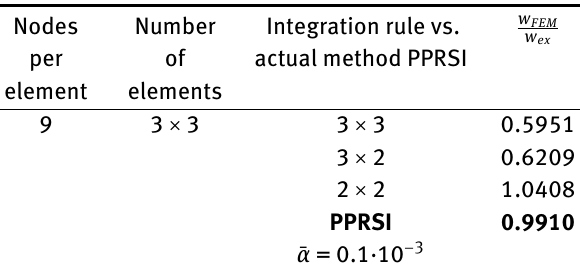
Table 2: Comparison of FE models, using nine-nodes element, for vertical displacement under the uniform vertical gravity load: finite element solution and PPRSI vs. exact solution